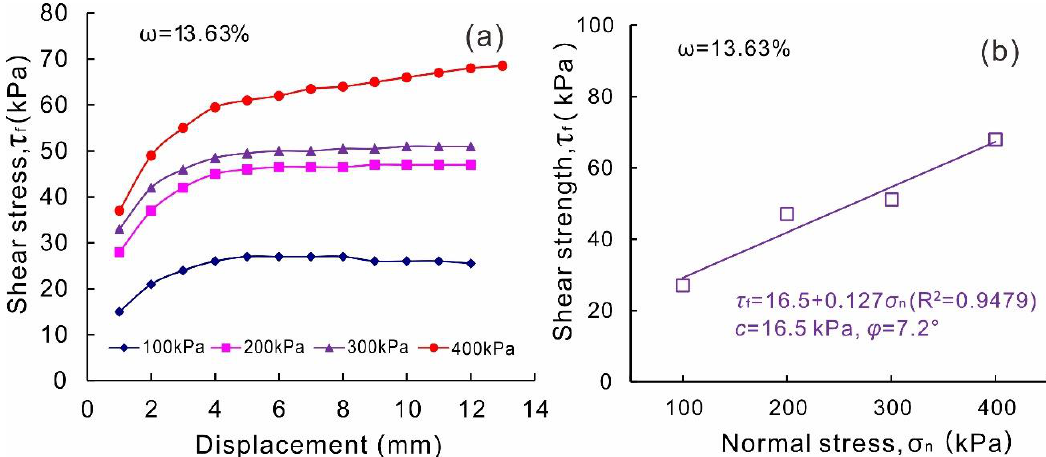
Figure 12. Indoor direct shear test results of the 2-mm-sieved slip zone soil of the Riverside Slump I# of the Huangtupo landslide with water content of 13.63%. ( a ) Shear stress vs. displacement under various normal stress; ( b ) shear strength vs. normal stress.